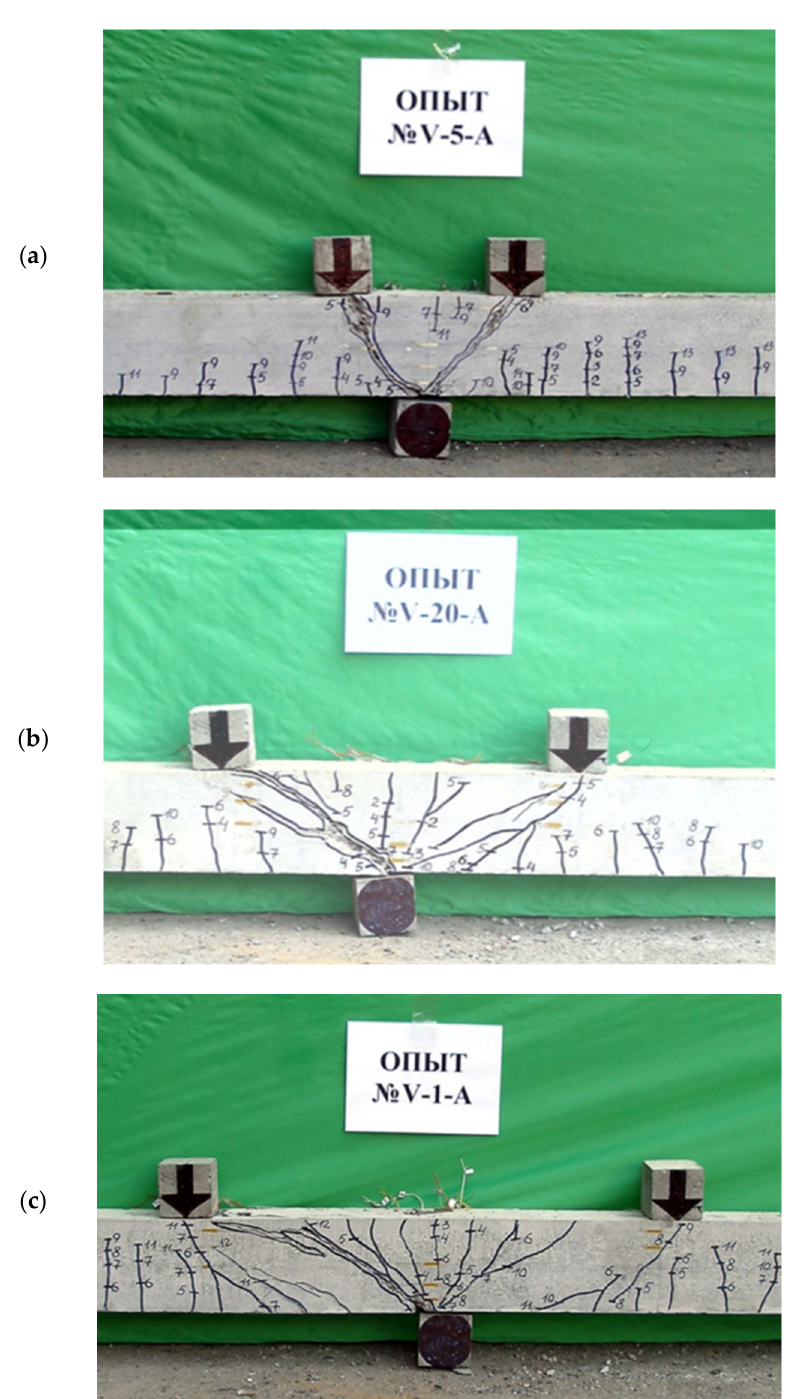
Figure 5. The nature of cracking and fracture of prototype beams with ( a ) small, ( b ) medium, ( c ) large cut-off spans.